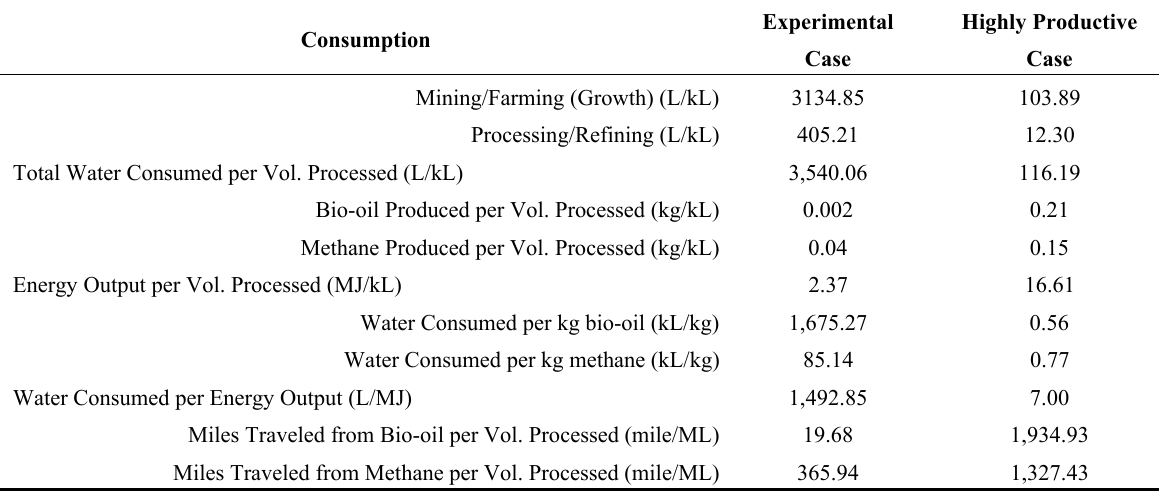
Table 6A. Water intensity of transportation from bio-oil and methane derived from the algal biofuel production